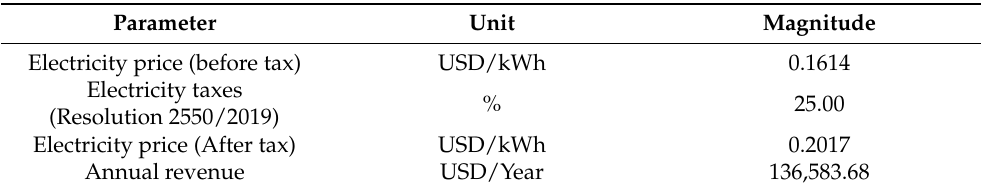
Table 8. Annual revenue from the gas microturbine and downdraft gasifier-based generation system using oxygen-enriched air as a gasification